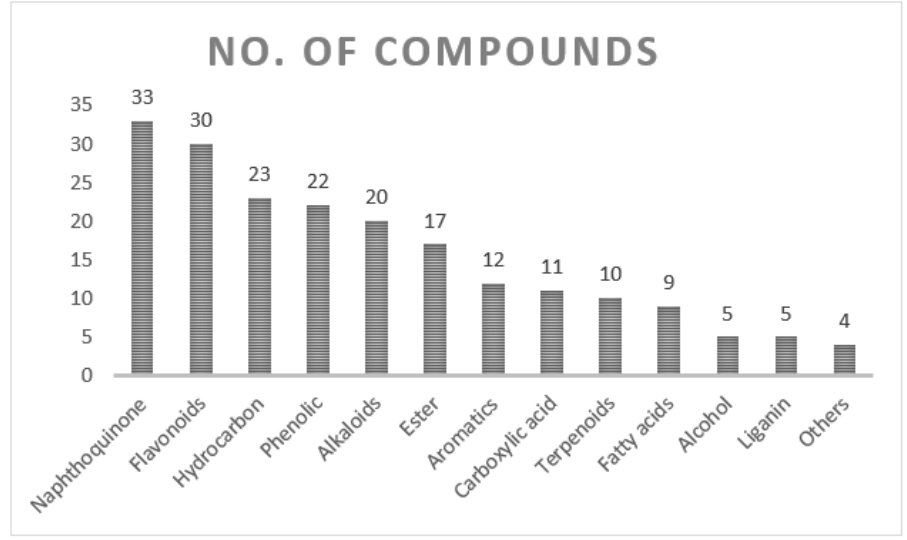
Figure 4. Organic class contents of Onosma species based on reported compounds. Table 3. Names and sources of compounds isolated from genus Onosma